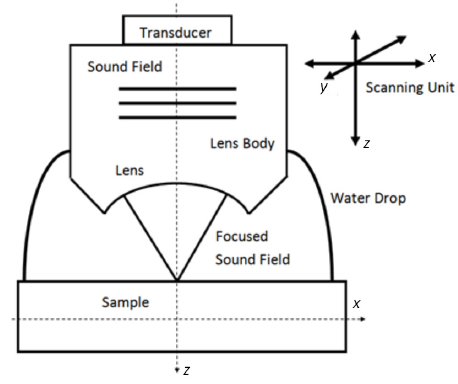
Figure 1. Schematic of scanning acoustic microscopy (SAM) principle.